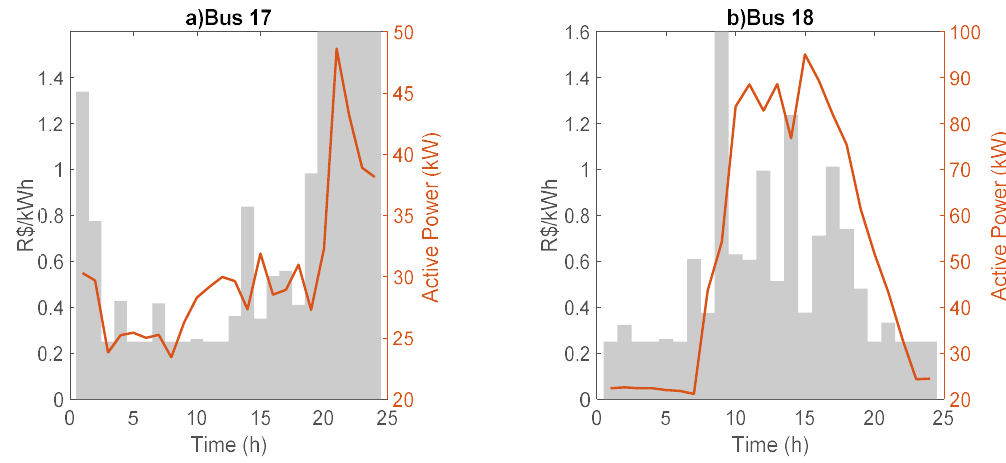
Figure 8. Dynamic tariff and demand. ( a ) Bus 17 (residential). ( b ) Bus 18 (commercial).